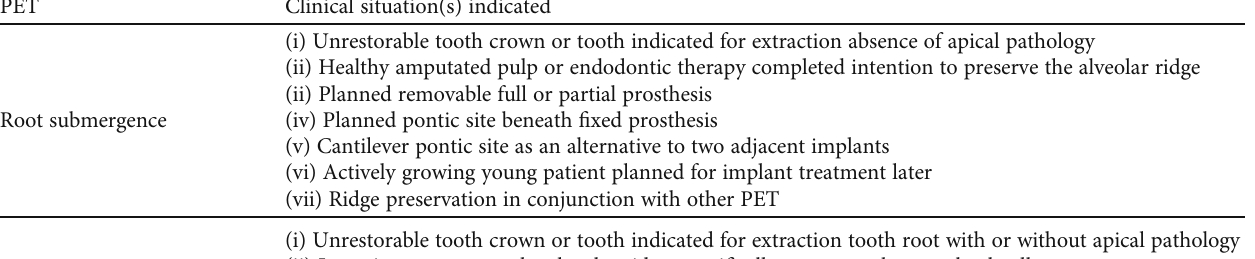
Table 1: Partial extraction therapies (PET) and their indications, adapted from Siormpas et al. [7]. PET Clinical situation(s)